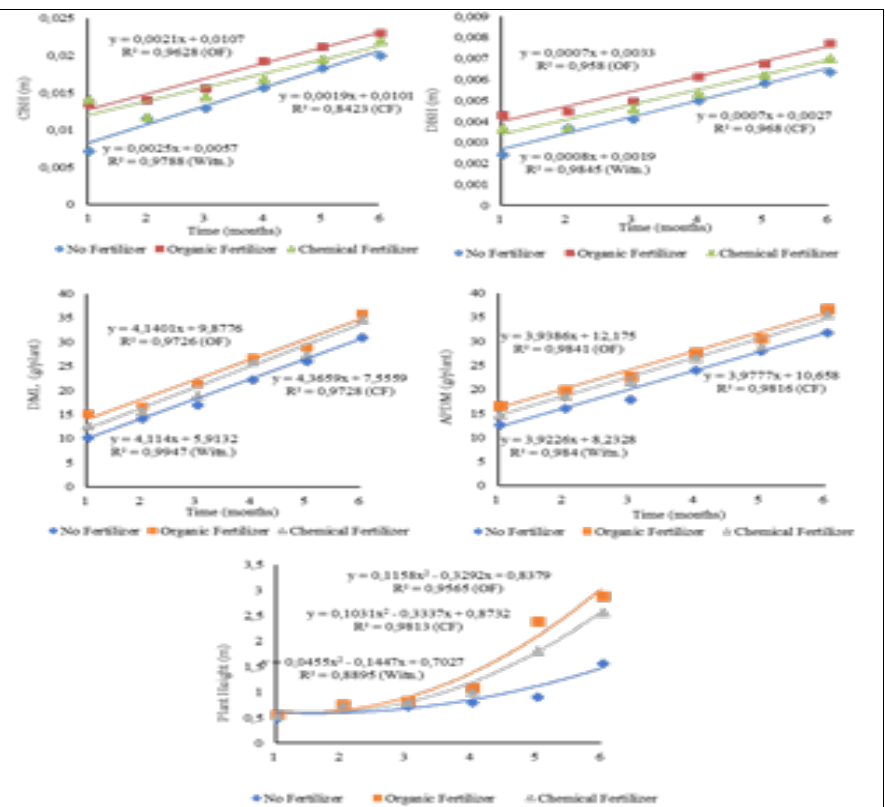
Figure 6: Circumference at Breast Height (CBH); Diameter at Breast Height (DBH); Dry Mass of Leaves (DML); Aerial Part Dry Mass (APDM) and Plant Height in the function of the three treatments